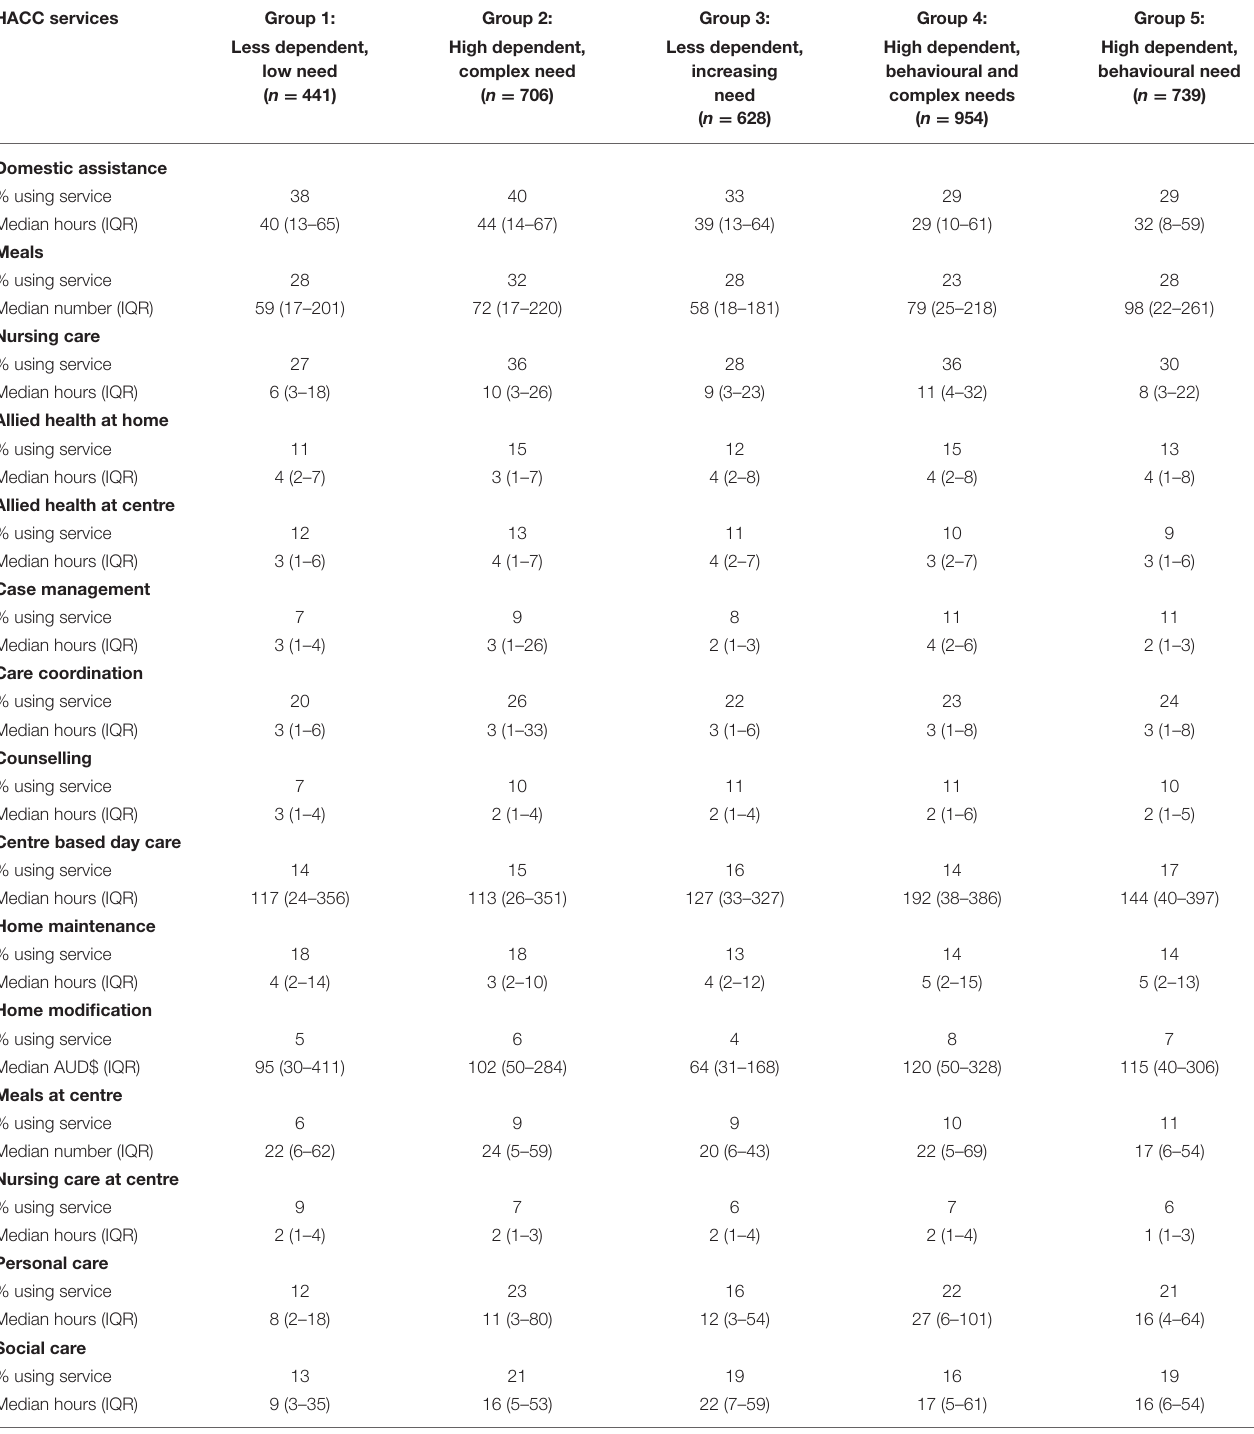
TABLE 1 | Proportion and median amount of HACC services for older Australian women over the 24 months prior to admission into RAC, according to the five trajectory groups in RAC ( n = 3,468). HACC